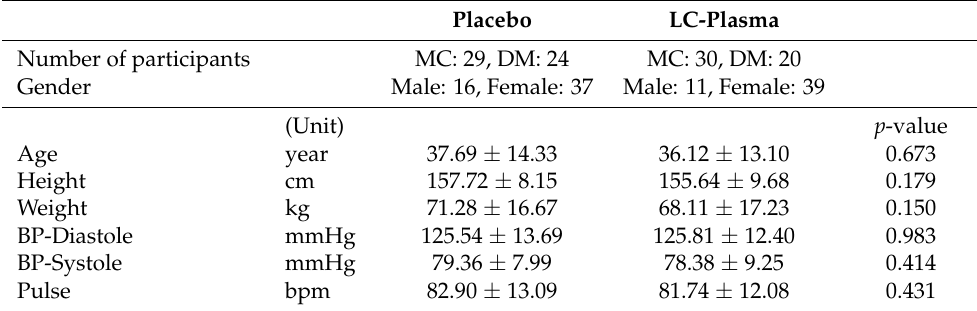
Table 1. Background data of